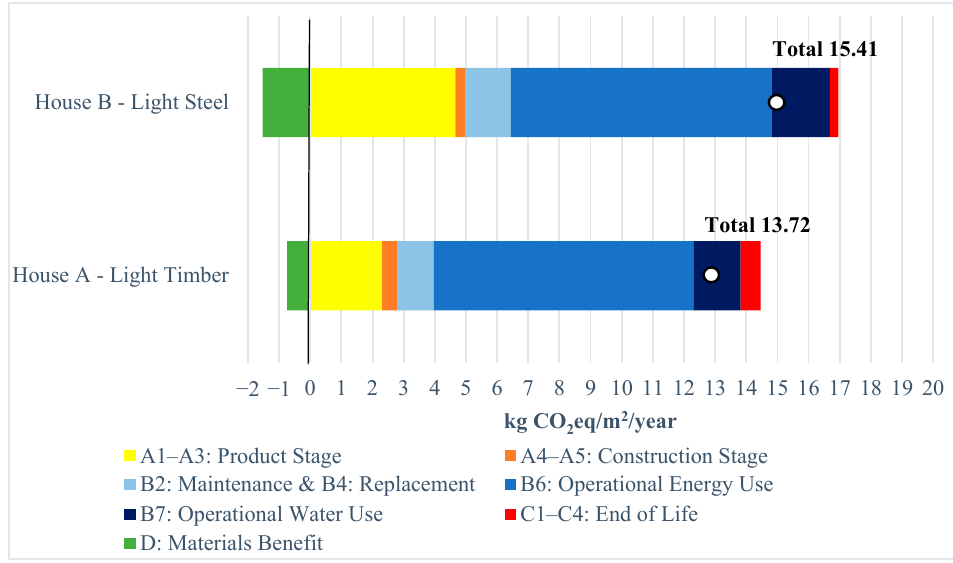
Figure 5. The comparative results of the GWP from the two houses.